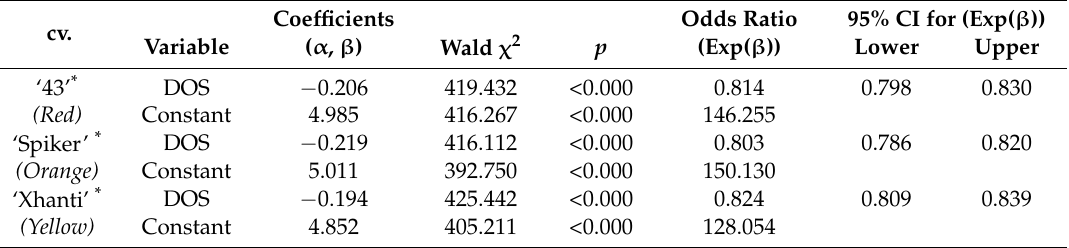
Table 2. Estimation of independent simple logistic regression parameters for each Tribelli XL ® pepper cultivar as a function of the number of days of storage (DOS) as a factor influencing the probability of